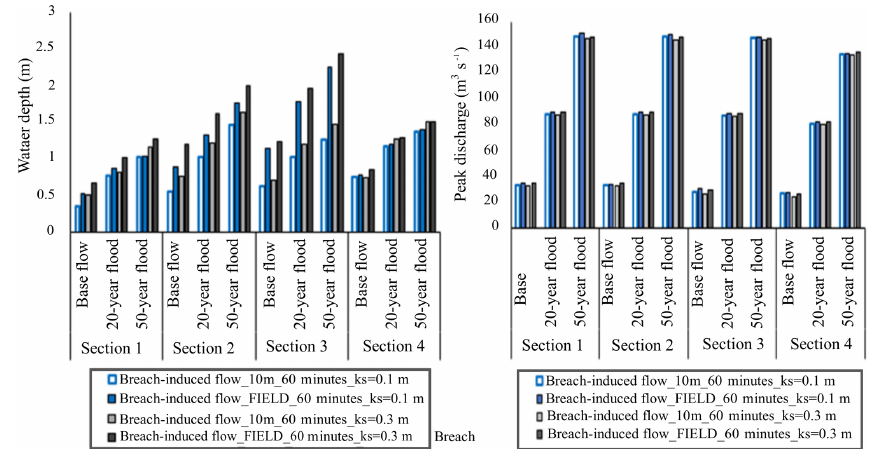
Figure 16. Water depth and peak discharge obtained from simulations based on the 10m × 10m DEM and from a topographic field survey. The breaching duration is